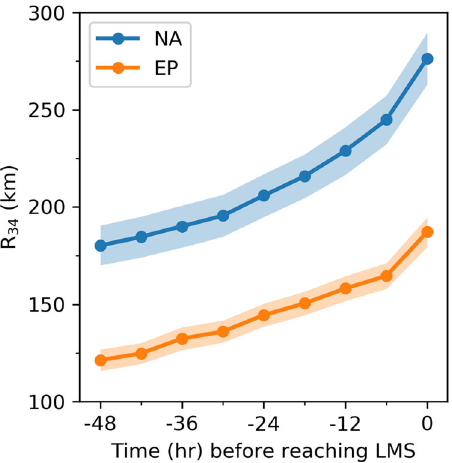
Fig. 2 Composite of R 34 for 48 h before NA and EP TCs reach the LMS at time 0. The solid lines show the mean evolution and the shading areas denote one standard error to the mean. The composites are based on 6-h observations (dots). There are 94 and 107 TCs used in the NA and EP, respectively.